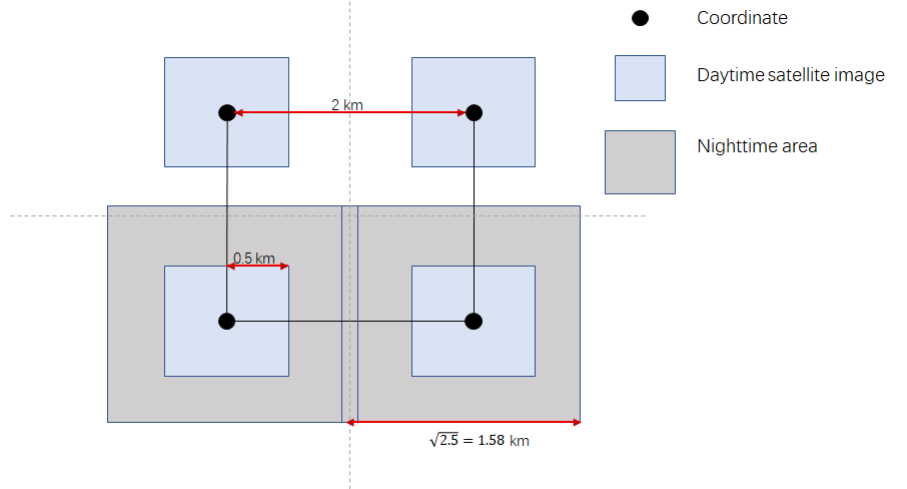
Figure 1. The brief procedures of collecting and matching data. There are three steps. (1) Deter- mine the interval between adjacent image centers (2 km in this paper) and calculate all the center coordinates across the Chinese Mainland. (2) Scratch a daytime satellite image covering an area of 1 km 2 centered on each coordinate. (3) Select an area of 2.5 km 2 centered on each coordinate and sum up the nighttime light intensities. The sum of nightlight intensities is then classified into 3 degrees, addressed as nightlight intensity level in this paper. The nightlight intensity level serves as the label for the daytime satellite image centered on the same